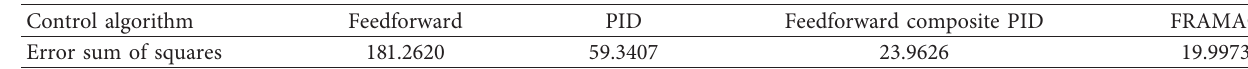
Figure 9: Results of FRAMAC. Table 1: Comparison of different control